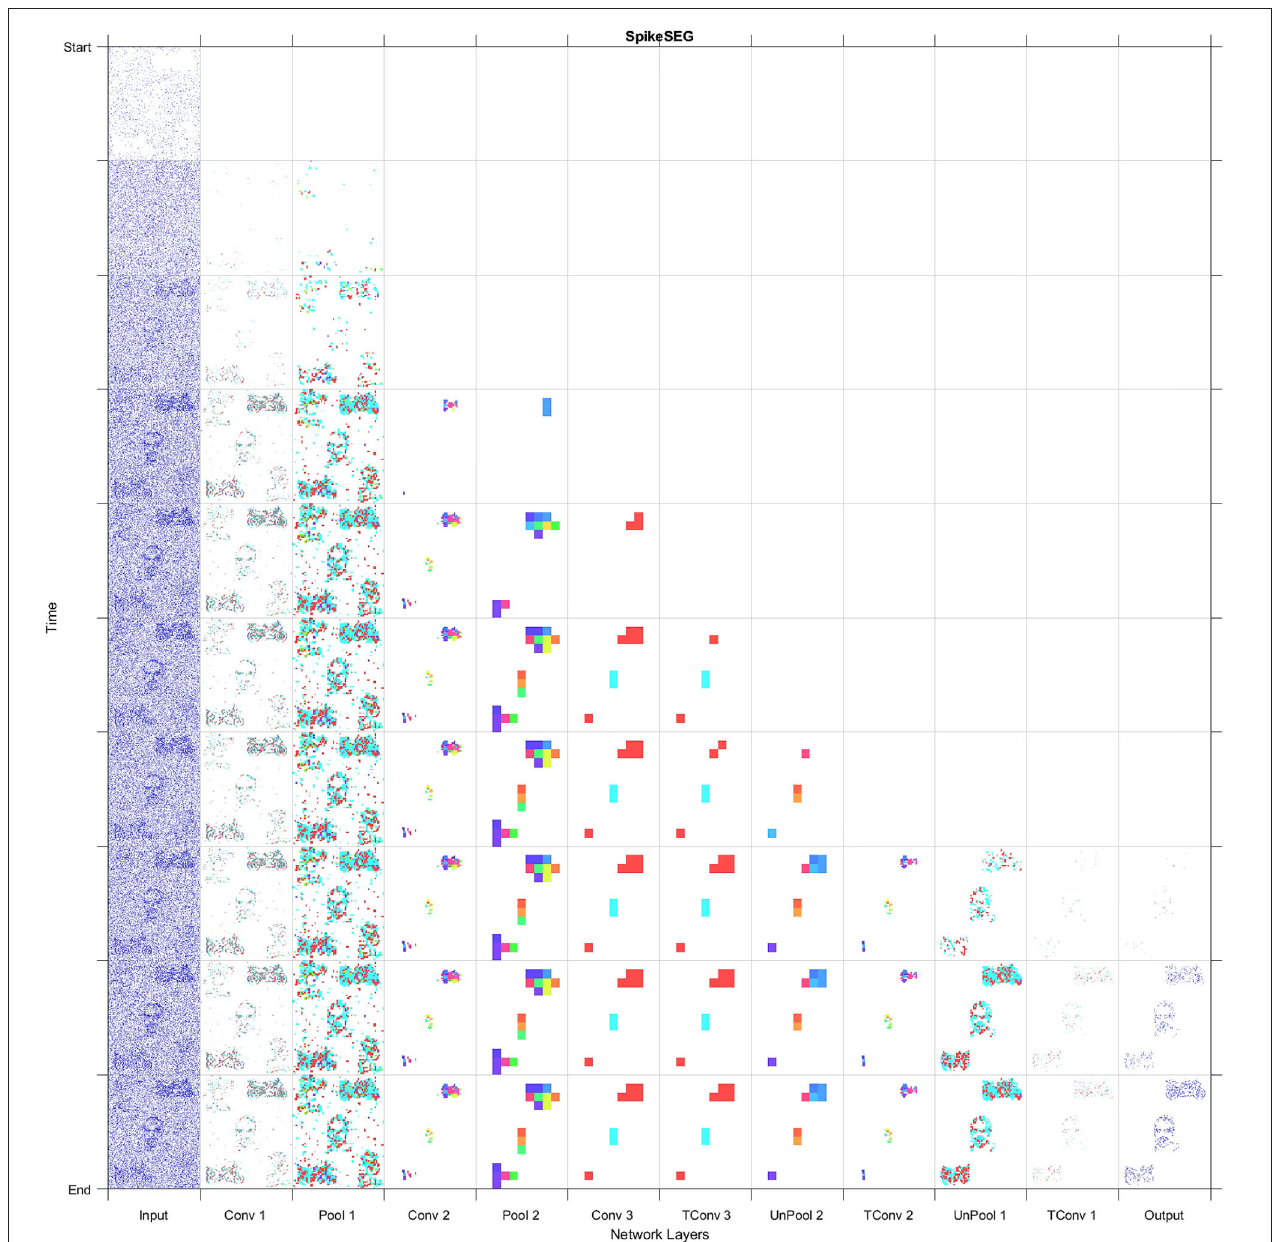
FIGURE 9 | Full Layer-wise spiking activity for the system, showing the progression of spikes through the network encoding then decoding section into the segmentation output.